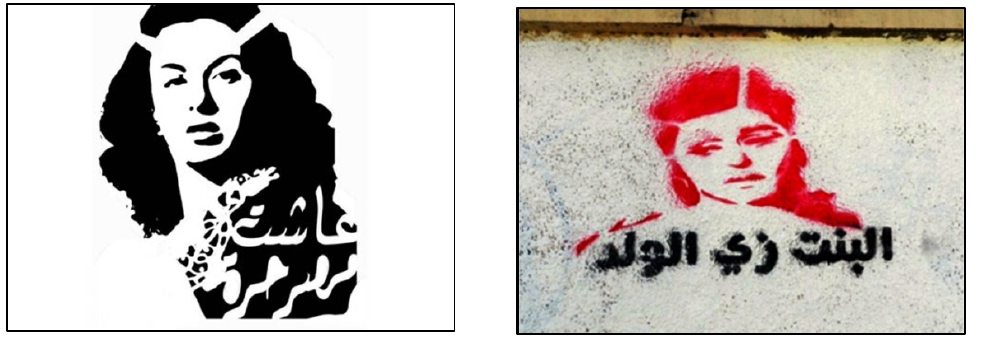
Figure10. Long live Free Egypt Figure 11. The girl is equal to the Boy